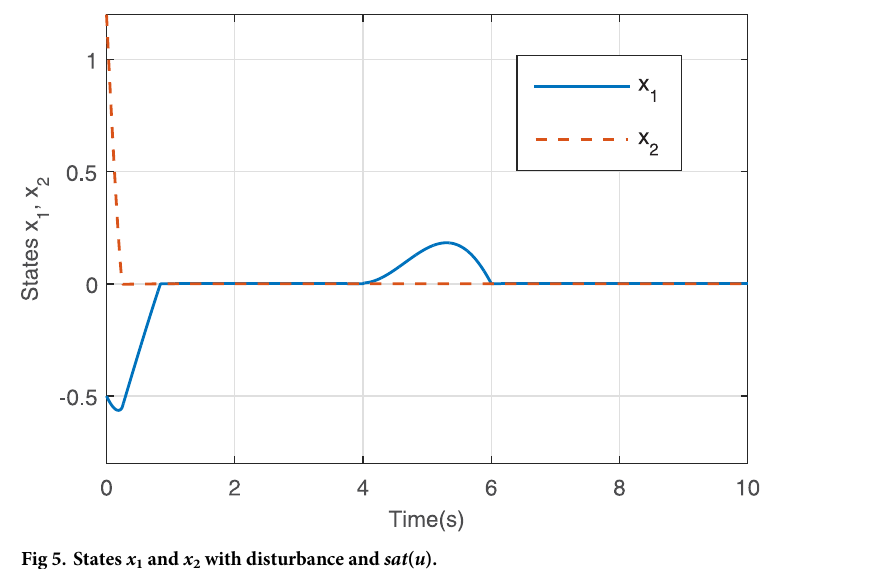
Fig 5. States x 1 and x 2 with disturbance and sat ( u ).